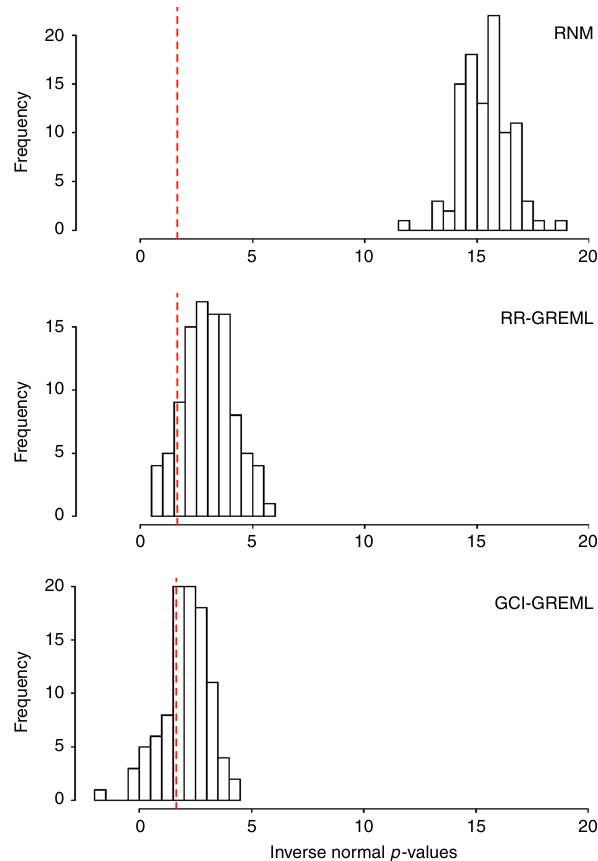
Fig. 3 RNM has more statistical power than RR-GREML and GCI-GREML. One hundred replicates of data were simulated under a model that assumed the presence of a genotype – covariate interaction. Simulation was based QCed ARIC data consisting 7,263 individuals and 583,058 SNPs. The model is speci fi ed as y = α 0 + α 1 × c + e with c = β + ε , all effects drawn from a multivariate normal distribution, where the variance – covariance structure between α 0 , β , and α 1 (in this order) is . For every replicate, each of the three models was fi tted to obtain a p -value for the G – C interaction via a comparison between the null (H 0 ) and alternative hypothesis (H 1 ) models using a likelihood ratio test. For RNM, the H 0 and H 1 models were y = α 0 + e and y = α 0 + α 1 × c + e . For RR-GREML and GCI-GREML, the H 0 and H 1 models were y = α 0 + e and y = α 0 + α 1 × c + e . In RR-GREML and GCI-GREML, samples were arbitrarily strati fi ed into four different groups according to the covariate levels. RR-GREML explicitly estimate residual variance for each of the four groups whereas GCI-GREML assumes homogeneous residual variance across the four groups and estimates a single residual variance. This fi gure shows the proportions of signi fi cant p -values, i.e., statistical power, for RNM, RR-GREML and GCI-GREML, which are 1, 0.9 and 0.69, respectively. Note that p -values are inverse normal transformed, such that the statistical signi fi cance level, i.e., 1.65, shown as dashed lines, is equivalent to the 0.05 level before the transformation mostly unbiased whether using GREML, LDSC or RNM (Fig. 5 and Supplementary Table 7). This implies that a consistent esti- mate of SNP-based heritability can be obtained across the methods given that the phenotypic variance is correctly estimated on the original scale, which is invariant to whether there are interactions or not. NATURE COMMUNICATIONS| (2019) 10:2239